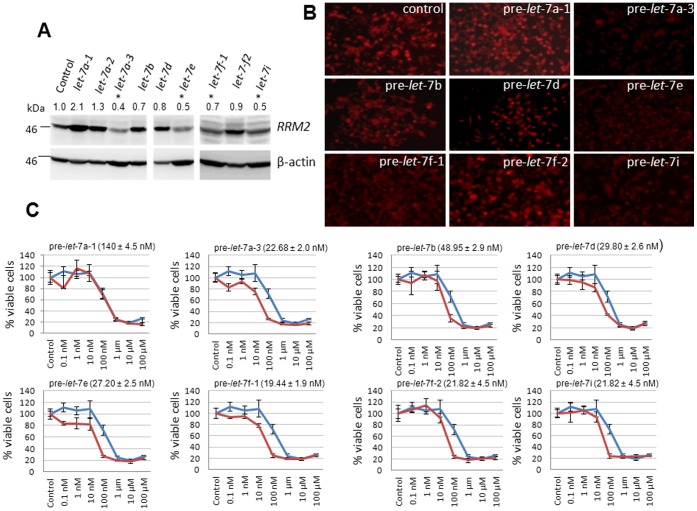
Differential RRM2 expression and gemcitabine chemosensitization by let-7 precursors in MIA PaCa-2.
A, Western blotting analysis of RRM2 (∼45 kDa) and β-actin (45 kDA) in whole cell lysates of MIA PaCa-2 overexpressing precursors of let-7 family members. Ratios of RRM2 to β-actin band intensities (normalized to control) from three experiments are indicated (top). Asterisks indicate significant reductions (p<0.05) in RRM2 levels compared with control. B, Immunocytochemical detection of RRM2 in exponentially growing MIA PaCa-2 overexpressing pre-let-7 family members. Original magnification, x20. C, MIA PaCa-2 cells stably overexpressing pre-let-7 family members (red) or vector alone (blue) were treated with gemcitabine (0.1 nM to 100 µM), and percent inhibition of cellular proliferation was measured using an MTT assay. Points, mean of triplicate; bars, SE. n = 3. Gemcitabine IC50 estimations indicated (parentheses).